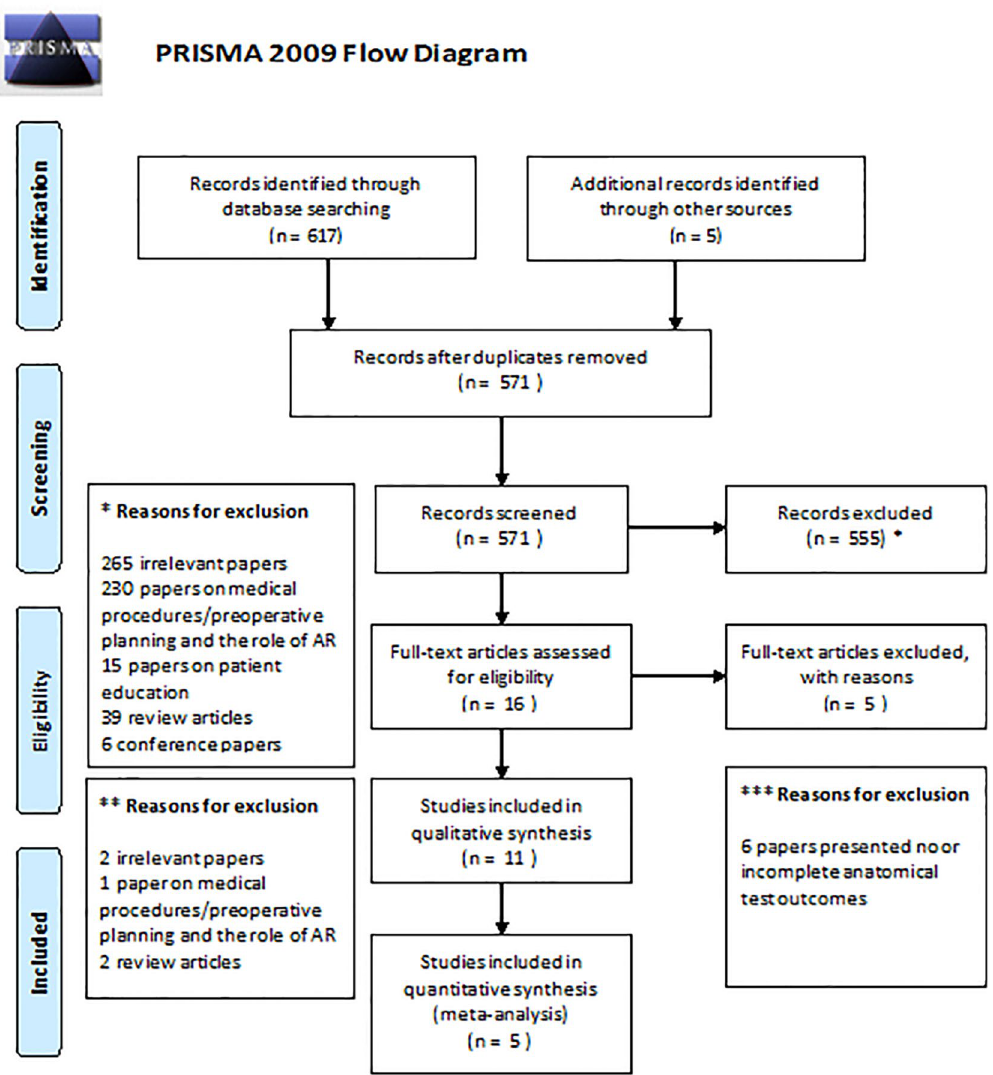
Figure 1. PRISMA flow diagram for the systematic review detailing the database searches, the number of abstracts screened and the full texts